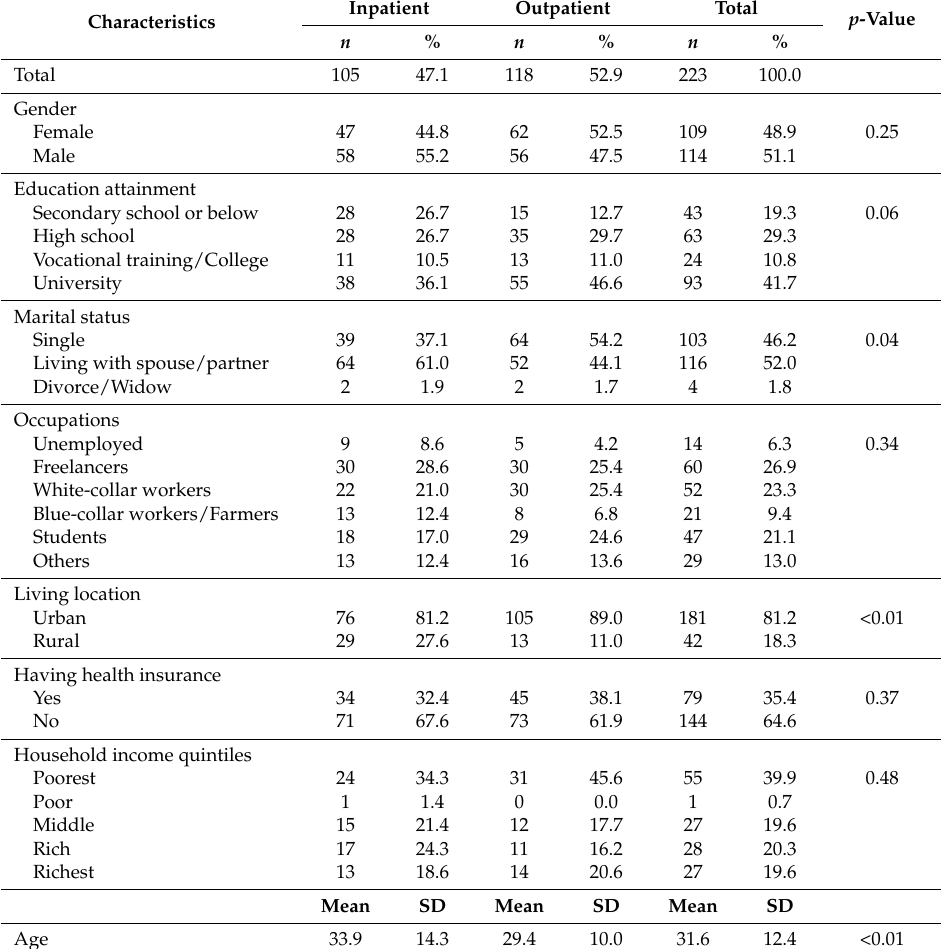
Table 1. Demographic characteristics of the